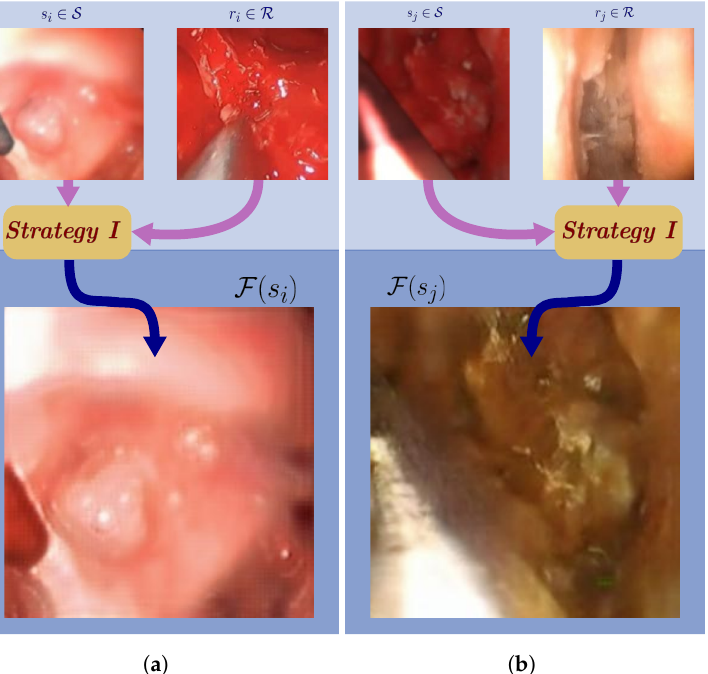
Figure 2. CycleGAN generated synthetic images from Strategy I : ( a ) The generated tool image adopts texture from the background; ( b ) the background adopts texture from the